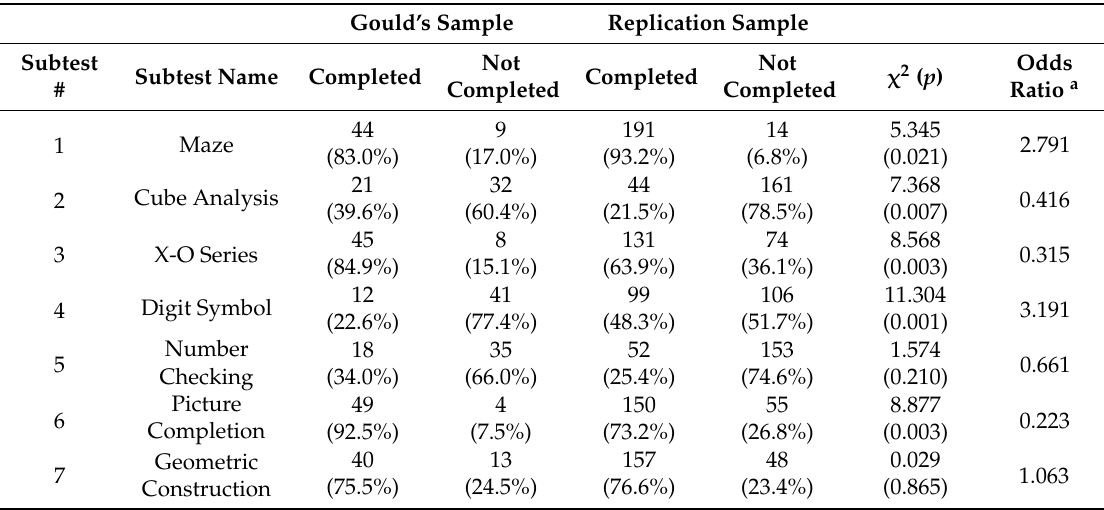
Table 1. Completion Counts for Army Beta Subtests in Gould’s [1] Sample and the Replication